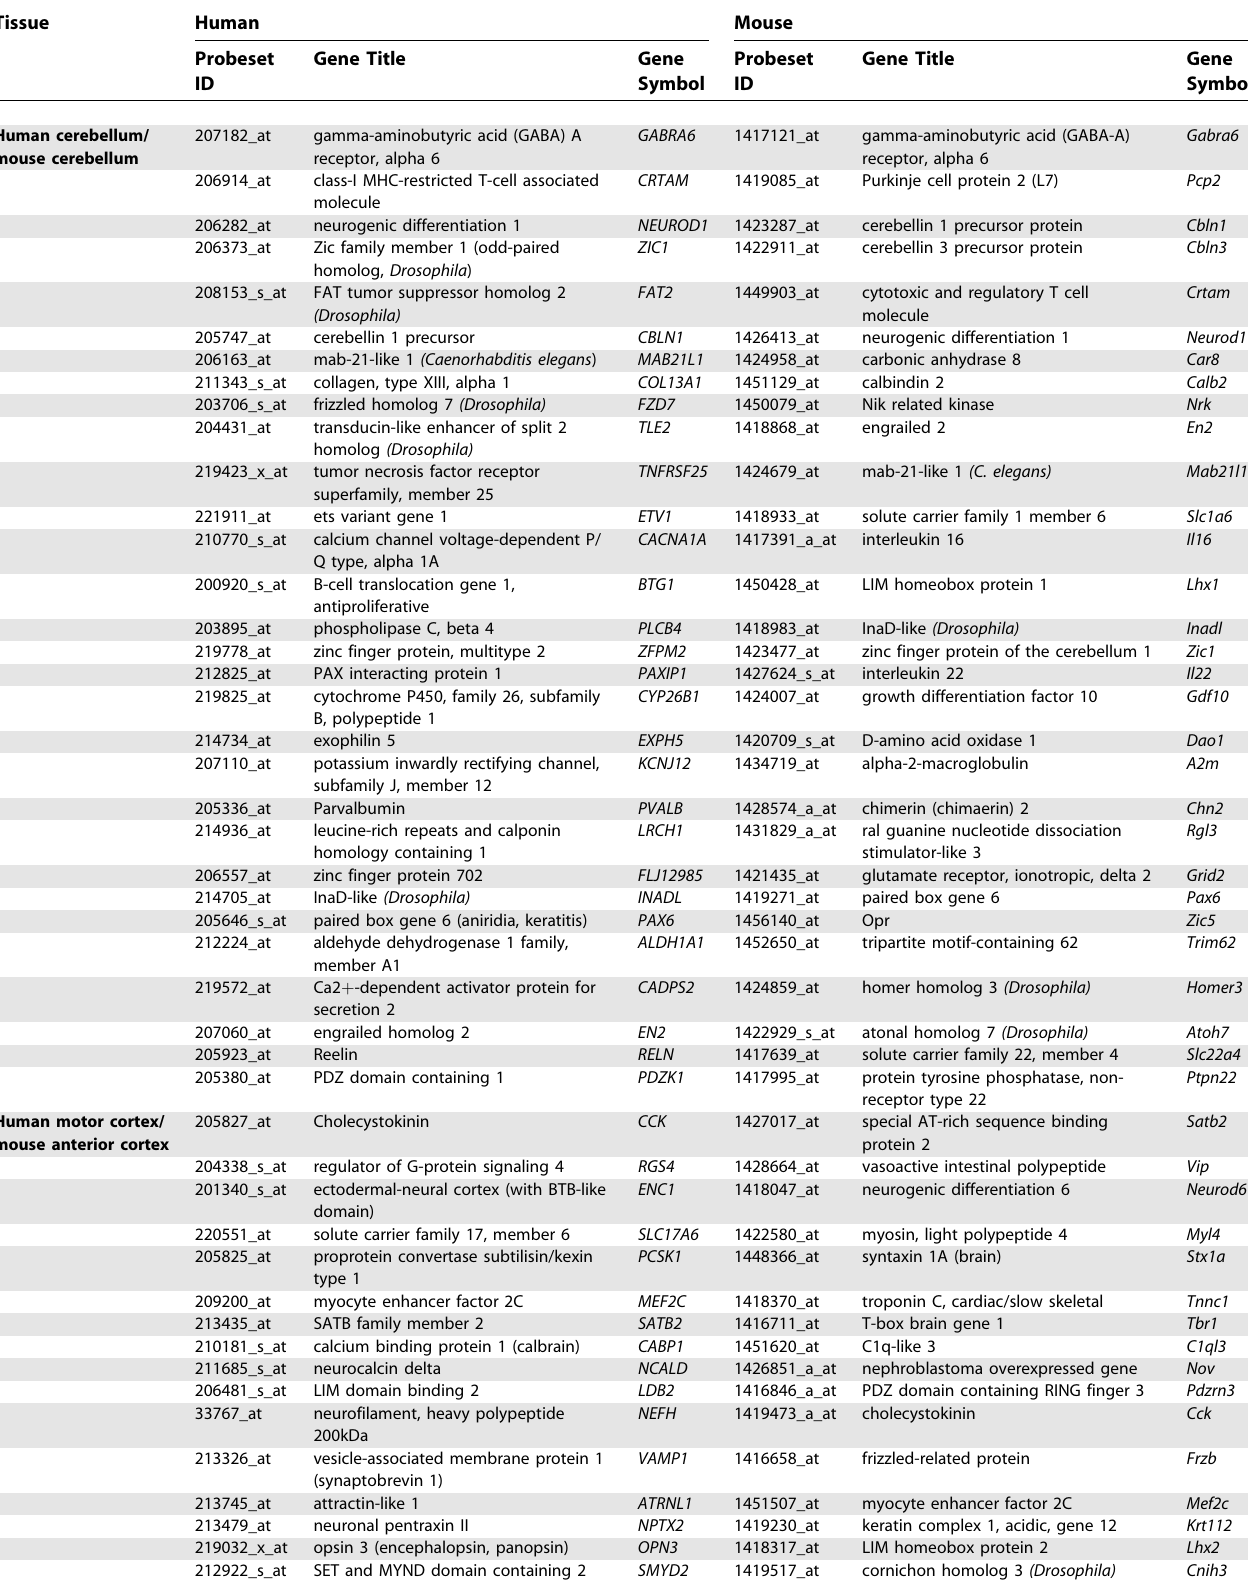
Table 3. Selected Regionally Enriched Genes in Human and Mouse Brain Tissues